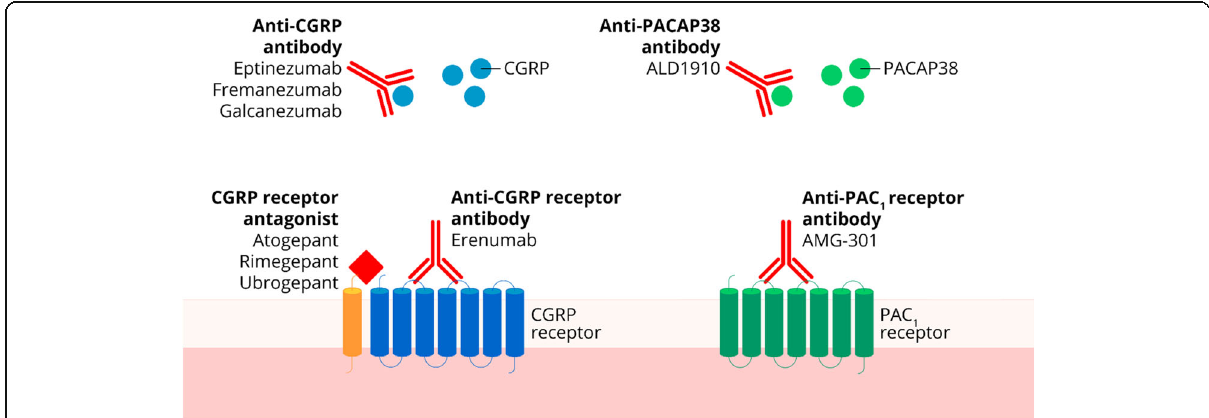
Fig. 3 Overview of the therapeutic novelties targeting the calcitonin gene-related peptide (CGRP) and pituitary adenylate cyclase-activating polypeptide/pituitary adenylate cyclase 1 (PACAP/PAC 1 ) pathways developed for migraine